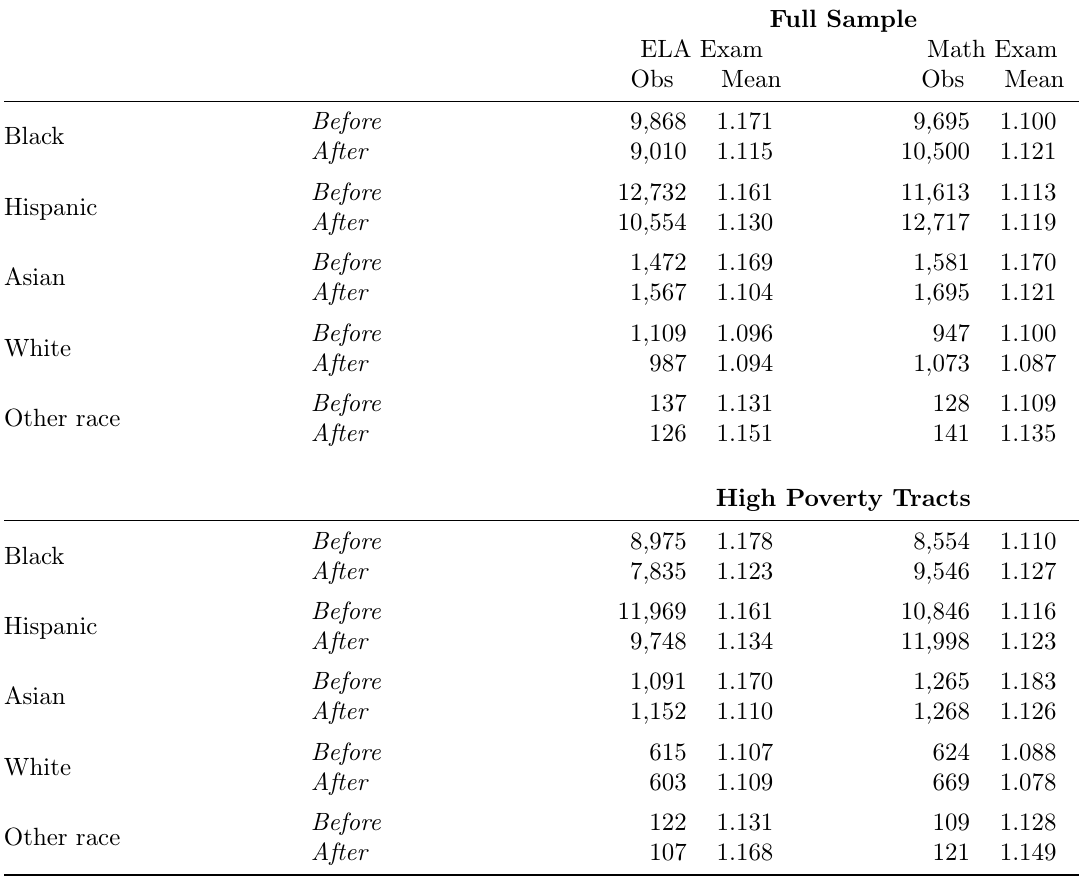
Table 1: Violent Crime Exposures within 7-Day Window, by